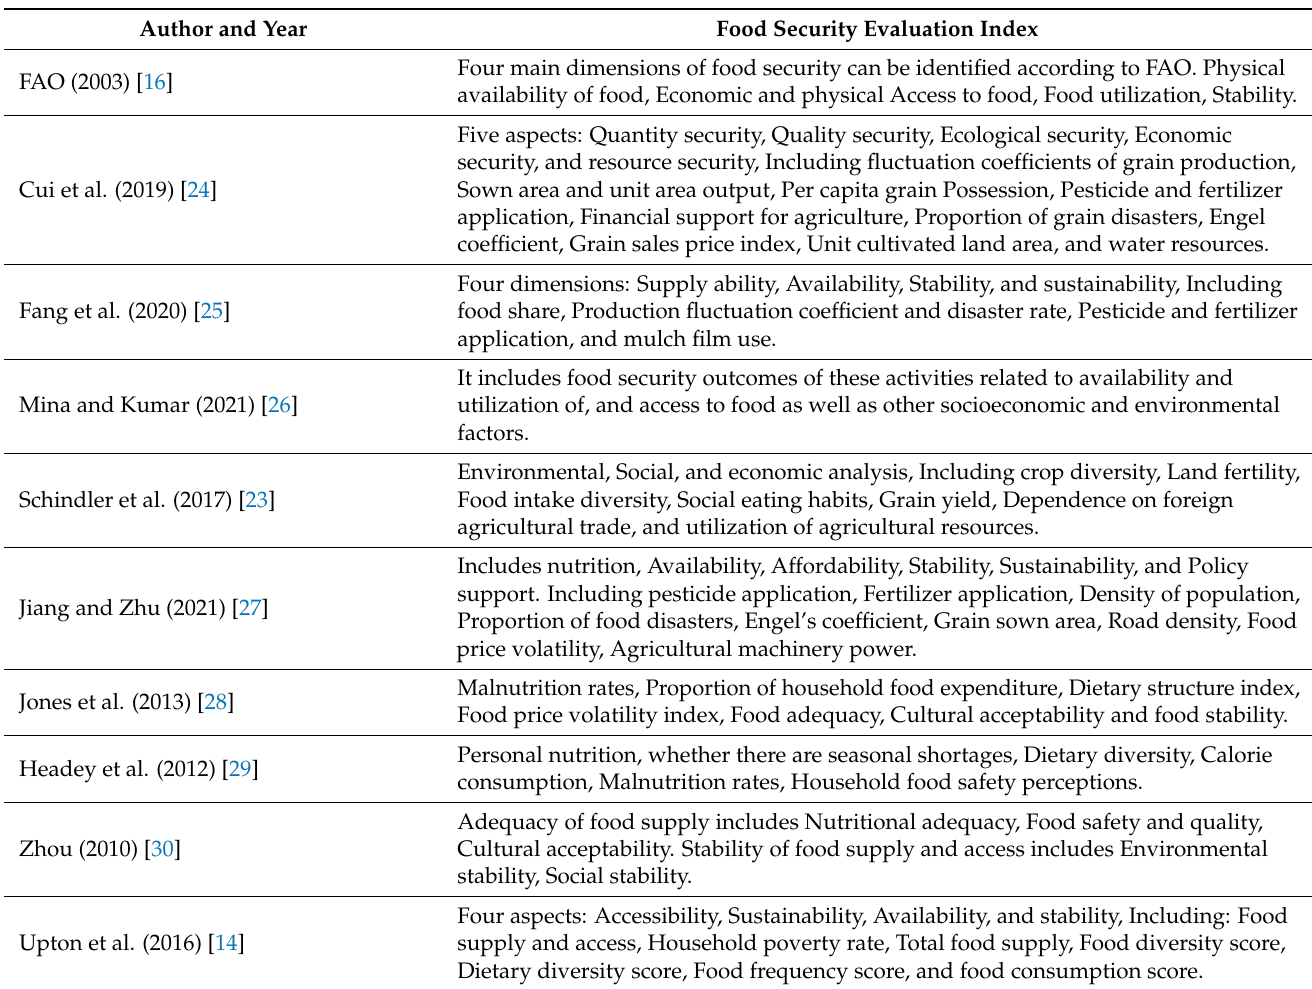
Table 1. Food security evaluation systems constructed by